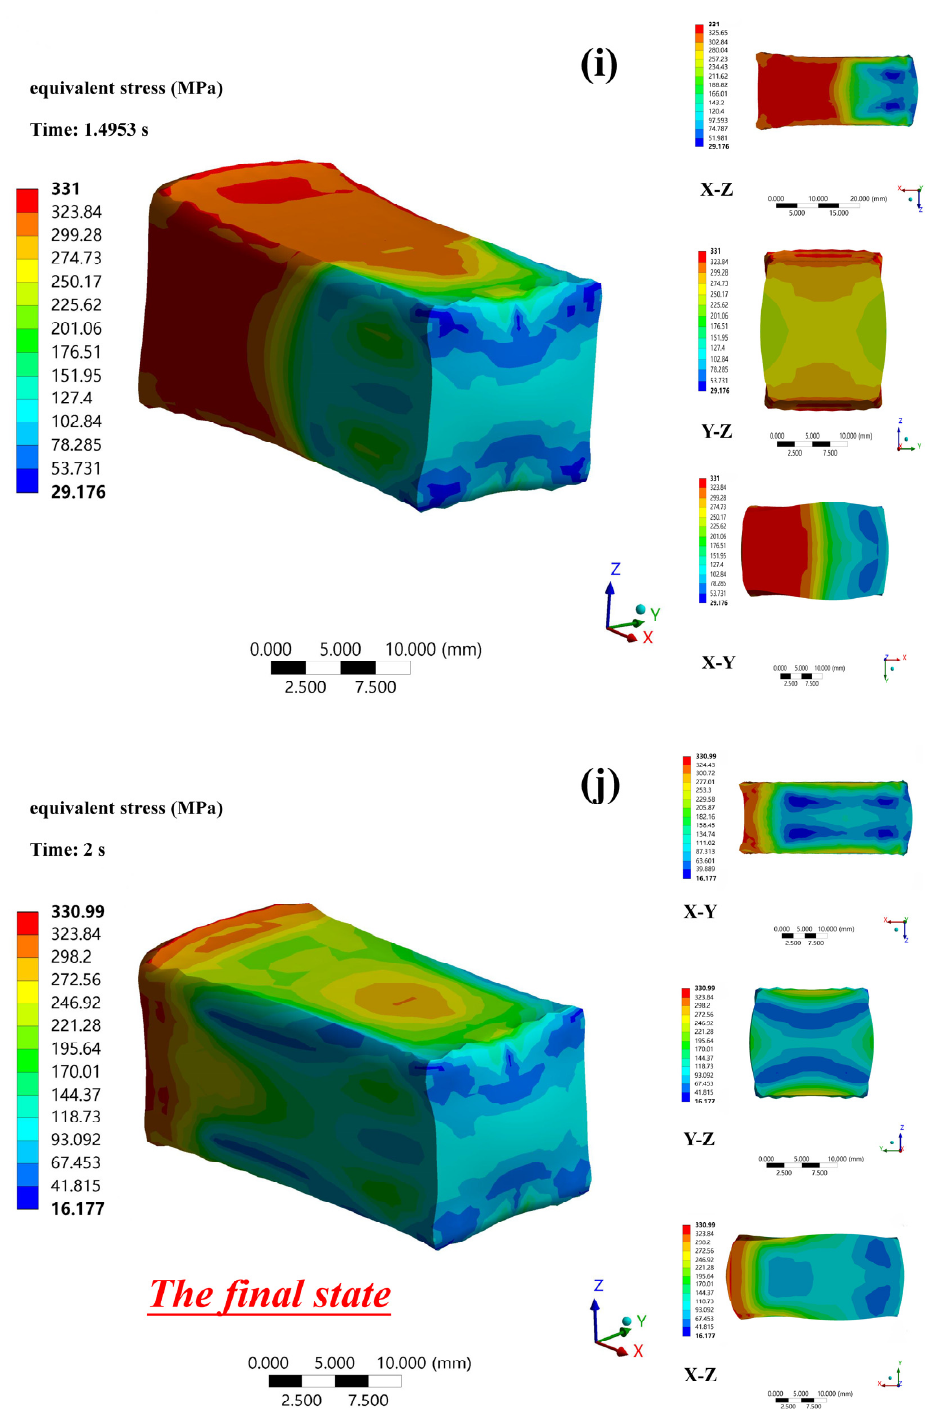
Figure 8. The equivalent stress distribution of MD rolled alloy. ( a ) Deformation of the rolled surface in 0.3225 s before turning over; ( b ) Deformation of the rolled surface in 0.56934 s before turning over; ( c ) Deformation of the rolled surface in 1.0065 s before turning over; ( d ) Deformation of the rolled surface in 1.5092 s before turning over; ( e ) Deformation of the rolled surface in 2 s before turning over; ( f ) Deformation of the rolled surface in 0.2225 s after turning over; ( g ) Deformation of the rolled surface in 0.5025 s after turning over; ( h ) Deformation of the rolled surface in 1.0125 s after turning over; ( i ) Deformation of the rolled surface in 1.4953 s after turning over; ( j ) Deformation of the rolled surface in 2 s after turning